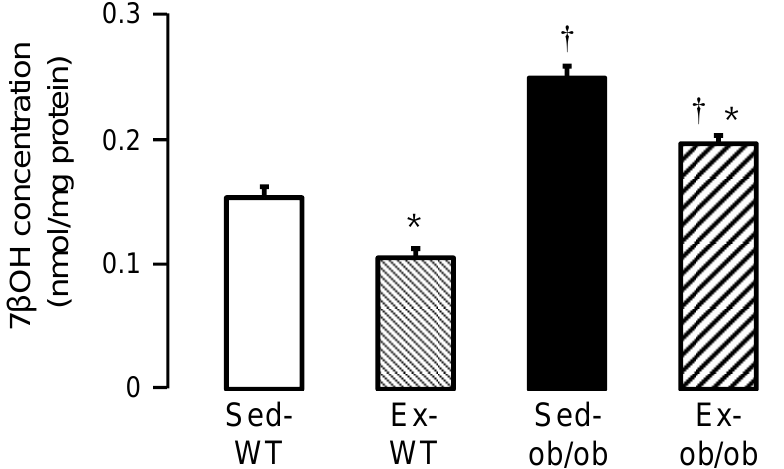
Figure 4. Cytosolic 7 β -hydroxycholesterol (7 β OH) concentrations in sedentary conditions (Sed) or after regular exercise (Ex) in wild-type (WT, n = 9 and 9, respectively) and ob/ob ( n = 7 and 10, respectively) mice. Values are expressed as mean ± SEM. * p < 0.05 vs. corresponding group. † p < 0.05 vs. corresponding WT group.